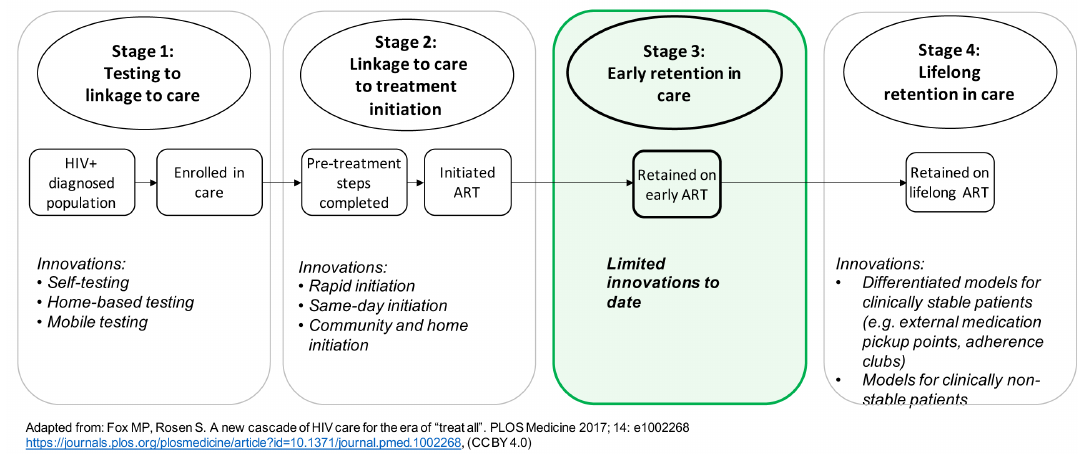
Figure 1. Innovations in service delivery along the HIV treatment cascade. Adapted from 23 under a CC BY 4.0